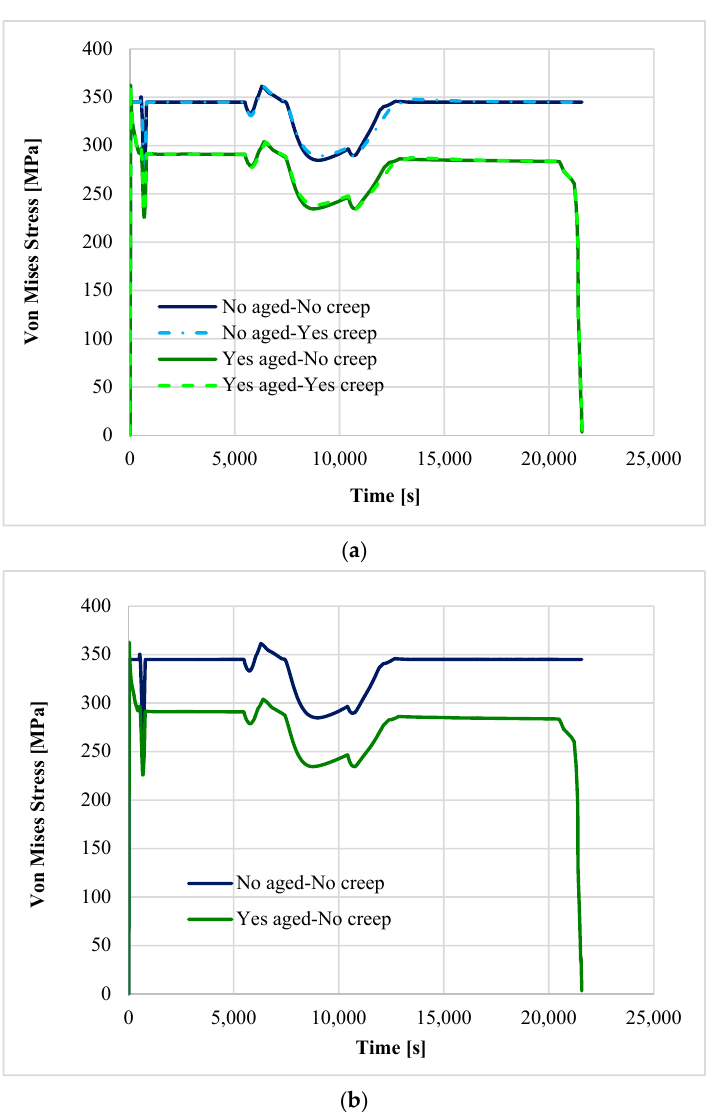
Figure 13. Comparison of the Von Mises stress trend for all four case studies ( a ) and only for the aged/not aged RPV (no creep) cases ( b ) at φ 0 ◦